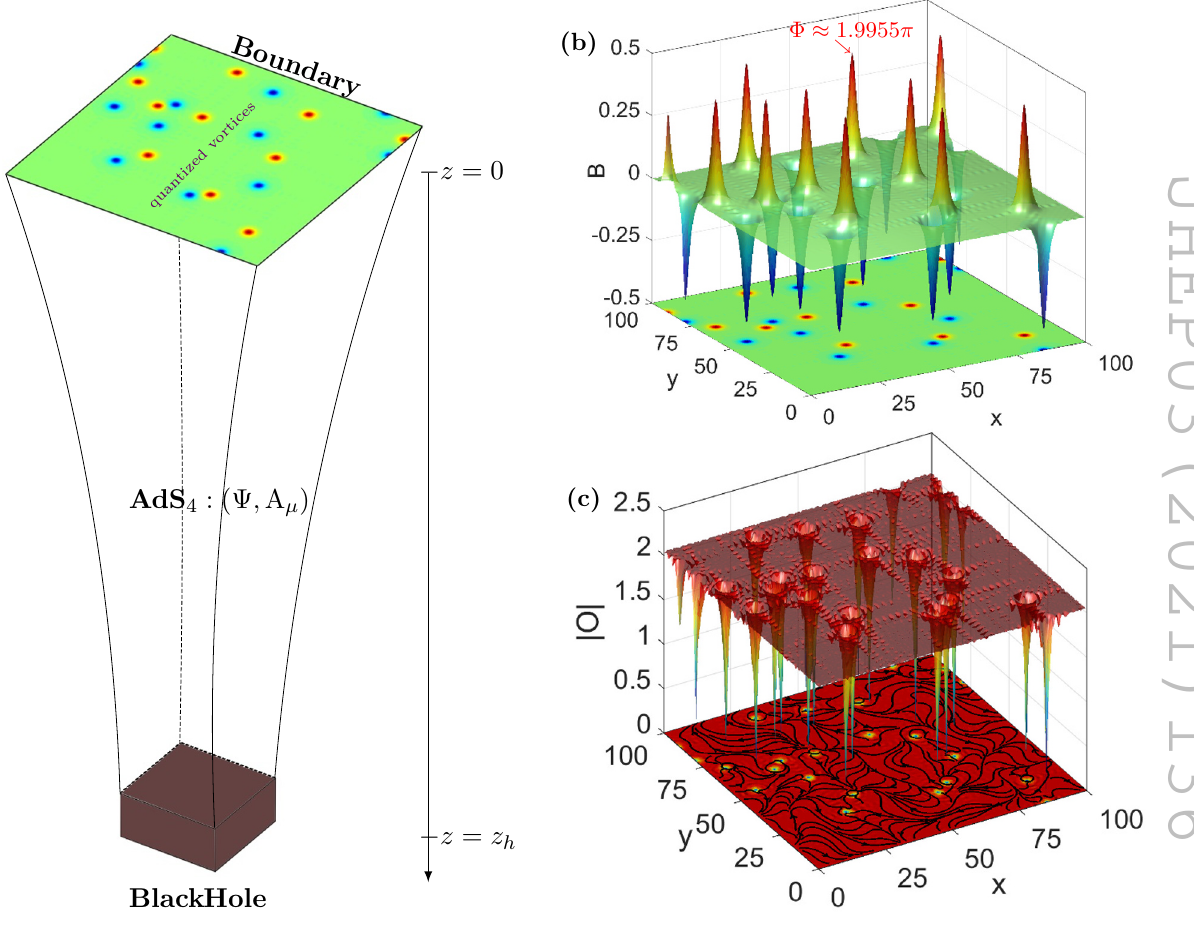
Figure 1. Holographic setup and birth of topological defects. (a) Complex scalar field Ψ and the U(1) gauge field A µ are living in the bulk of Schwarzschild-AdS 4 spacetime. Quenching temperature across the critical point induces quantized vortices on the (2+1)-dimensional boundary, leading to the holographic KZM. (b) Configurations of the magnetic fluxons and their corresponding locations are shown at the bottom. Red arrow points at a positive magnetic fluxon with magnetic flux Φ ≈ 1 . 9955 π . (c) Configurations of the order parameter vortices and the density plot at the bottom. Streamlines with arrows indicate the directions of phases in the complex plain of the order parameter. Locations of the cores of the vortices and the positions of the magnetic fluxons in panel (b) coincide. For related movie see the supplementary